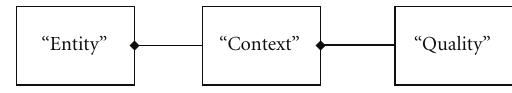
Figure 2: Context modeling approach.